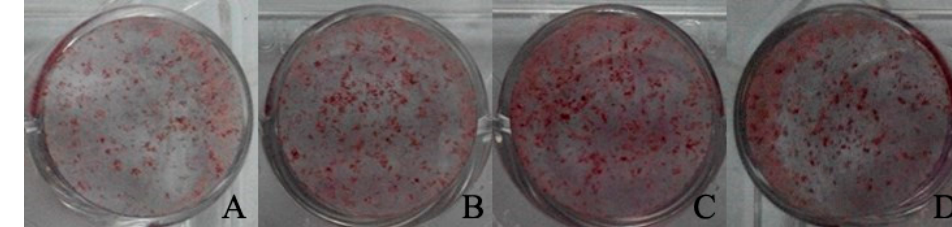
Figure 6. Effect of baicalin at various concentrations on mineralized nodule formation 12 days after osteogenic induction. ( A ) CON; ( B ) baicalin at 1 μ M; ( C ) baicalin at 10 μ M; ( D ) baicalin at 50 μ M. Table 3. Intensity scanning of mineralized nodule formation 12 days after osteogenic induction ( n = 4). Group Area (mm 2 /Well) Number (Mineralized Nodule/Well)